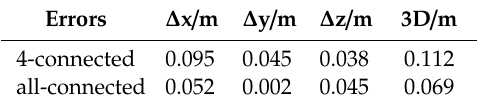
Table 2. Average orbital errors of 60-LEO constellation with di ff erent link topologies.